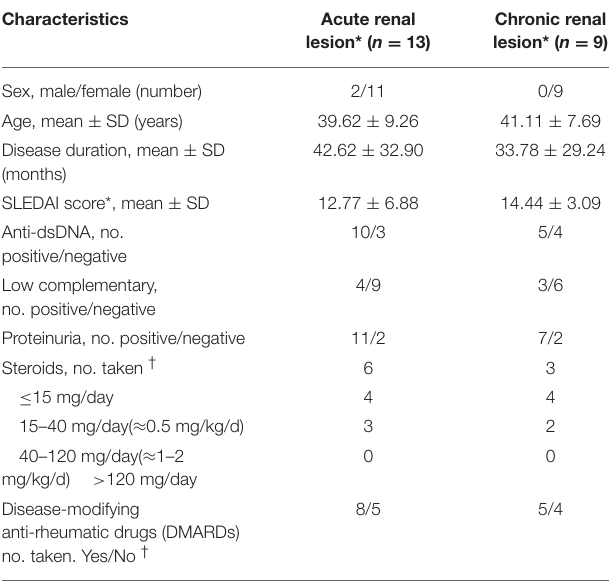
TABLE 1 | Demographic, clinical, and laboratory characteristics of LN